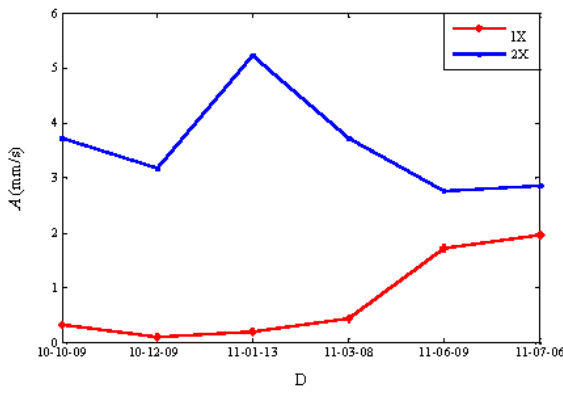
Figure 7. The trends of the amplitude value by the interpolation method for the discrete spectrum of the No. 2H sensor.